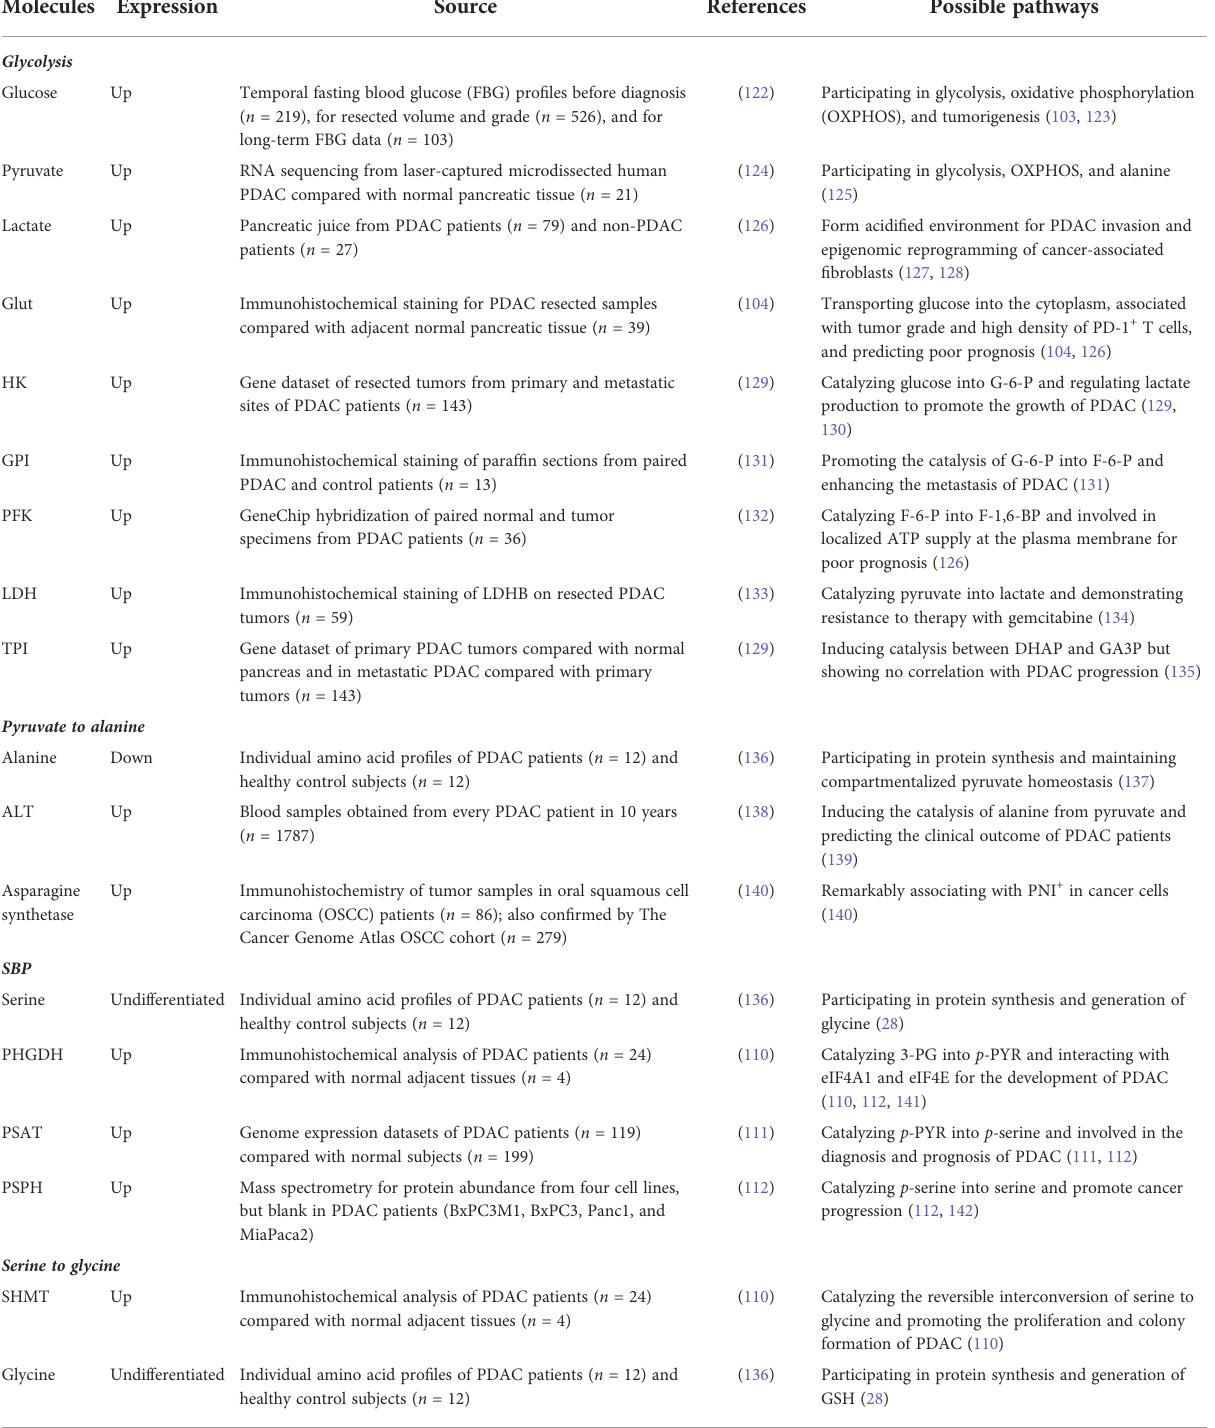
TABLE 1 Clinical evidence of metabolic expression for detection in pancreatic ductal adenocarcinoma (PDAC). Molecules Expression